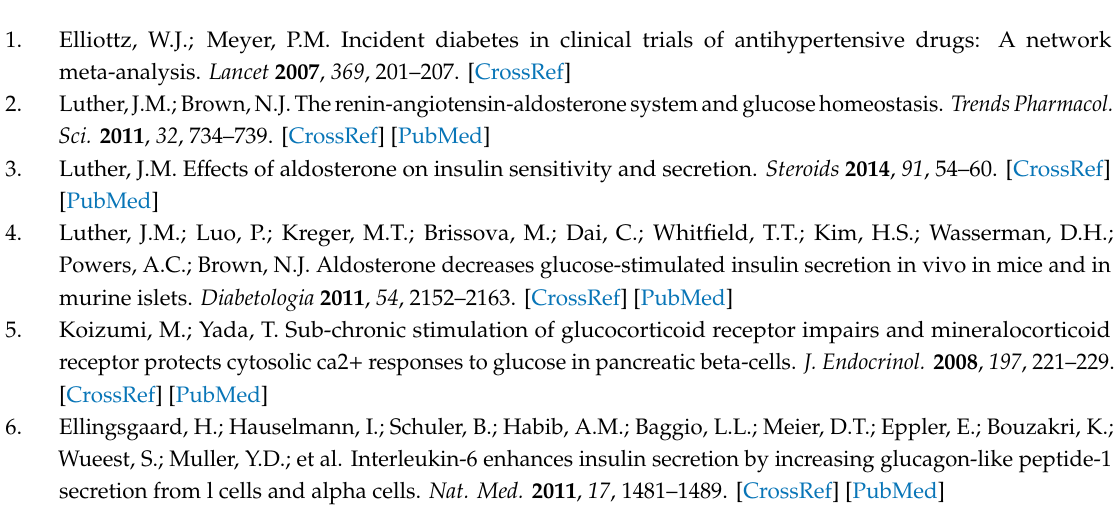
Figure S1: Inflammation and endoplasmic reticulum stress in PA model rodents, Figure S2: Alteration of mRNA levels in α TC cells, Figure S3: Relationship between MR, GR and IL-6 mRNA expression in pancreatic islet cells, Figure S4: Evaluation of IL-10 mRNA levels in α TC cells. Figure S5: Evaluation of mRNA levels in MIN6 cells, Figure S6: Evaluation of 11 β -HSD2 mRNA levels in MIN6 and α TC cells, Table S1: List of qPCR primers, Table S2: List of siRNA sequences, Table S3: List of qPCR primers and sense sequence for mutated MRE. Author Contributions: Conceptualization, R.G.; methodology, R.G.; software, R.G.; validation, K.O., S.K.,